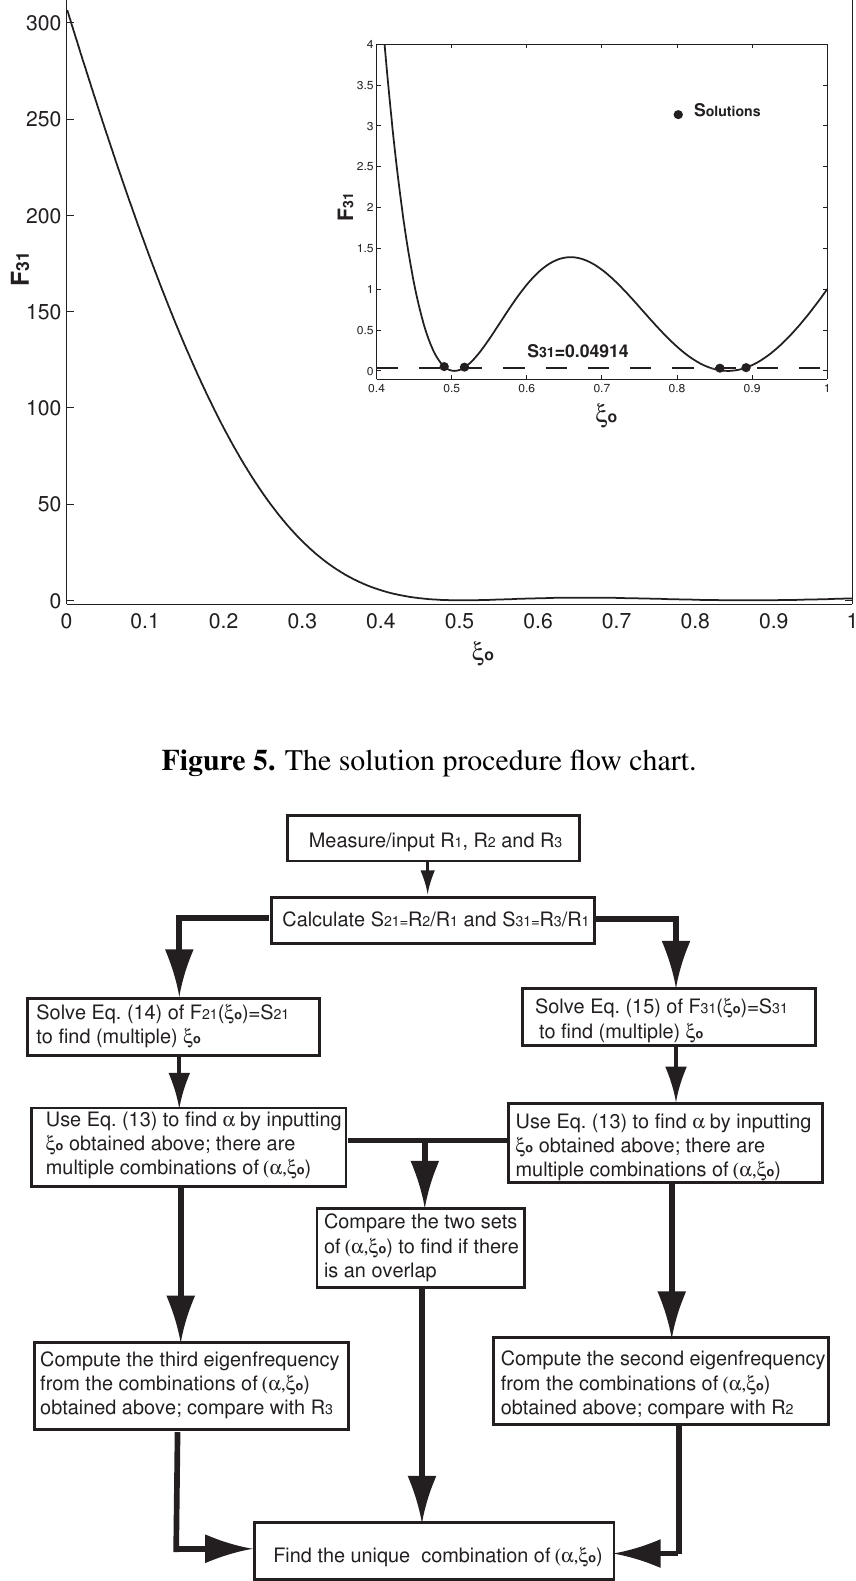
Figure 4. F as a function of ξ . The inset shows the four solutions when S 31 o ≤ 1 when S There are four ξ solutions in 0 . 451 ≤ ξ o o < 0 . 451 when S > 1 . in ξ o 31